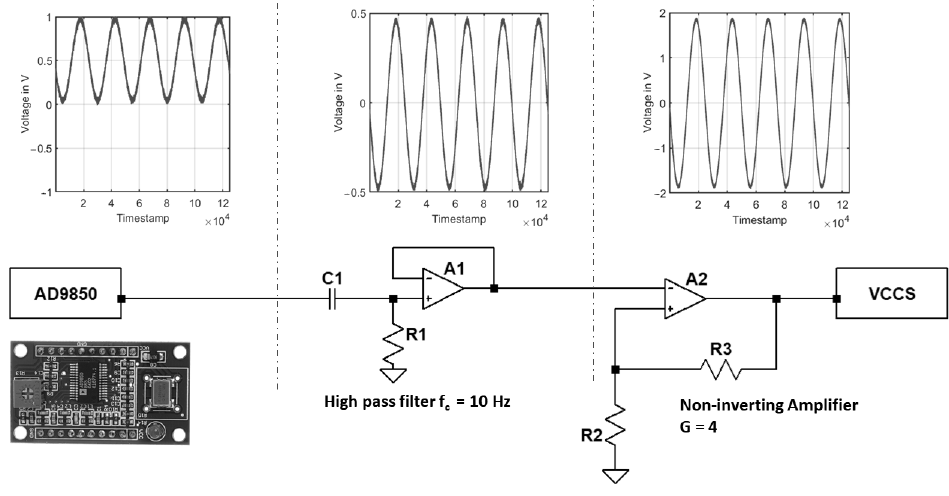
Figure 4. Signal generator module based on AD9850